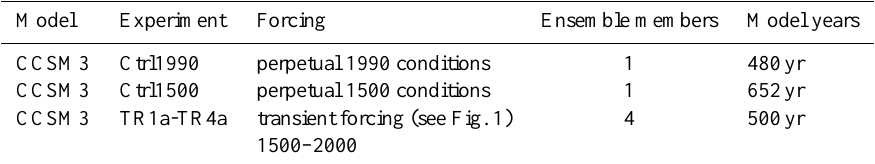
Table 1. Overview of the simulations used in this